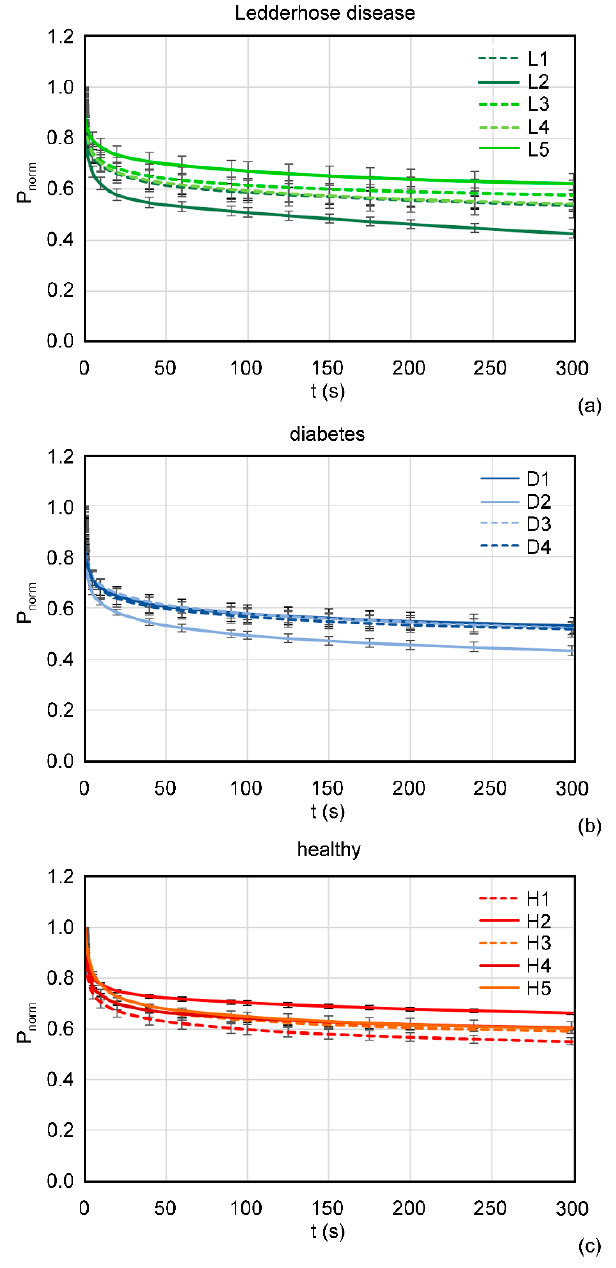
Figure 5. Results of stress relaxation tests at 8% strain, in terms of normalized stress P norm (mean values ± SE) vs. time, for PF of subjects with Ledderhose disease ( a ), diabetes ( b ) and healthy subjects ( c ).